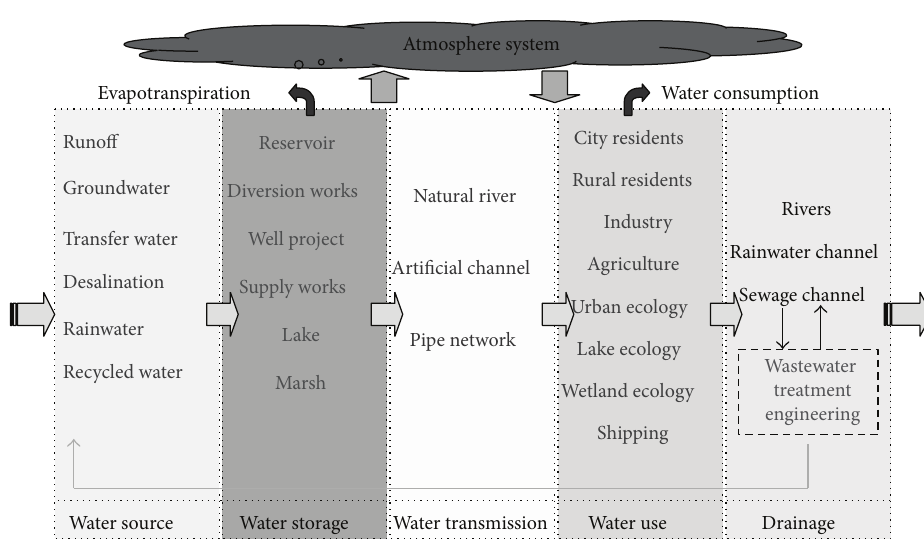
Figure 3: Description of the water system in